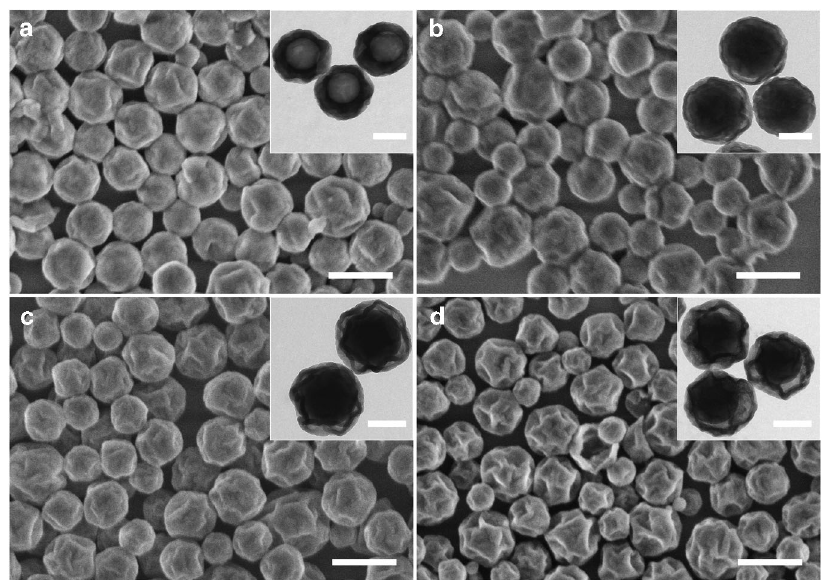
Fig. 2 In fl uence of fractions of inner water phase. The mass ratio of water to the oil phase (PEOS:styrene 1:1) in the primary W/O emulsion is systematically varied: a 2:10. b 3:10. c 4:10. d 6:10. The mass ratio of the primary W/O emulsion to the outer water phase is 1:10. FESEM images with scale bars representing 500 nm are shown and the insets are the corresponding TEM images with scale bars of 200